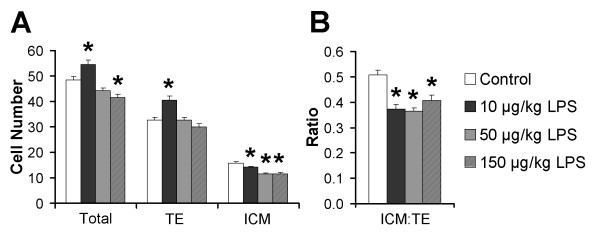
GD 3.5 blastocysts from LPS-treated dams have fewer ICM cells and reduced ICM:TE cell ratios vs. controls. (A) Mean total, TE and ICM cell numbers and (B) ICM:TE cell ratios. All values represent means ± SEM. *P ≤ 0.05 vs. control (n = 33 to 50 blastocysts per treatment; n = 4 to 8 mothers per treatment).